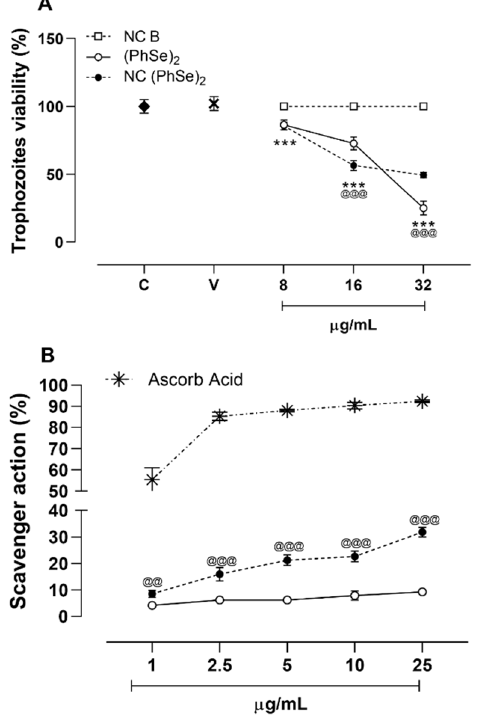
Figure 1. In vitro evaluation of anti- T. vaginalis activity against ATCC 30236 isolate ( A ) and DPPH scavenger assay of the formulations ( B ). Data are presented as mean and standard deviation. Statistical evaluations were performed by one ‐ way ANOVA followed by Tukey. (***) p < 0.001 denotes statistical difference between control and treatment; @ denotes statistical difference between (PhSe) 2 and NC (PhSe) 2 ; (@@) p < 0.01 and (@@@) p < 0.001.